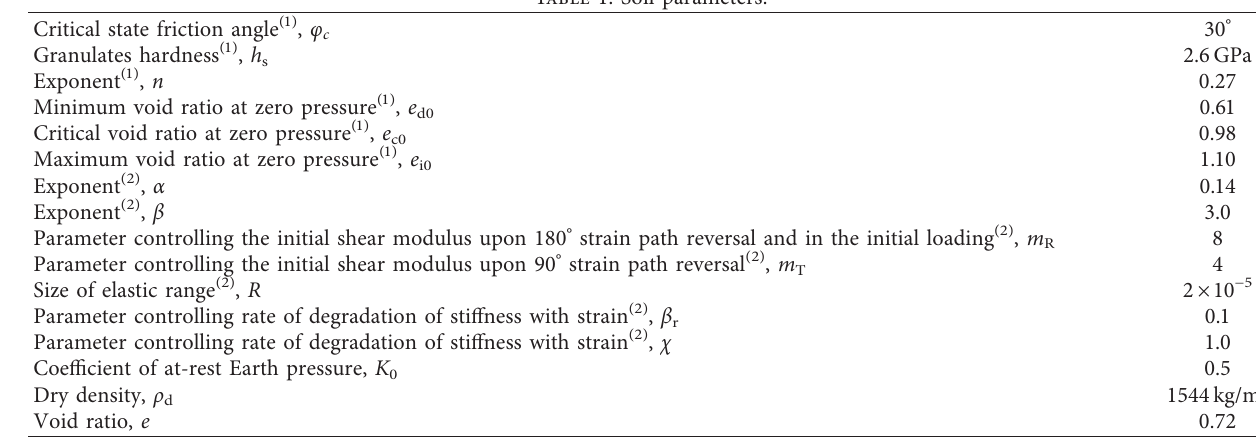
Figure 1: (a) Finite element mesh for case C; (b) finite element mesh for case S; (c) 3D stress state; and (d) layout of monitored sections. Model scale: 1: 60. Table 1: Soil